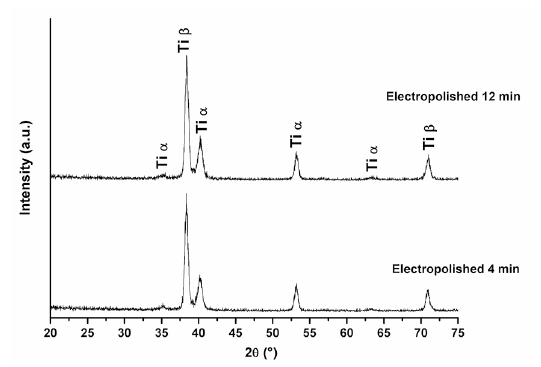
Figure 2. Grazing Incidence X-ray Diffraction (GIXRD) results (incidence angle from 5º) of the electropolished systems, treated for 4 min and 12